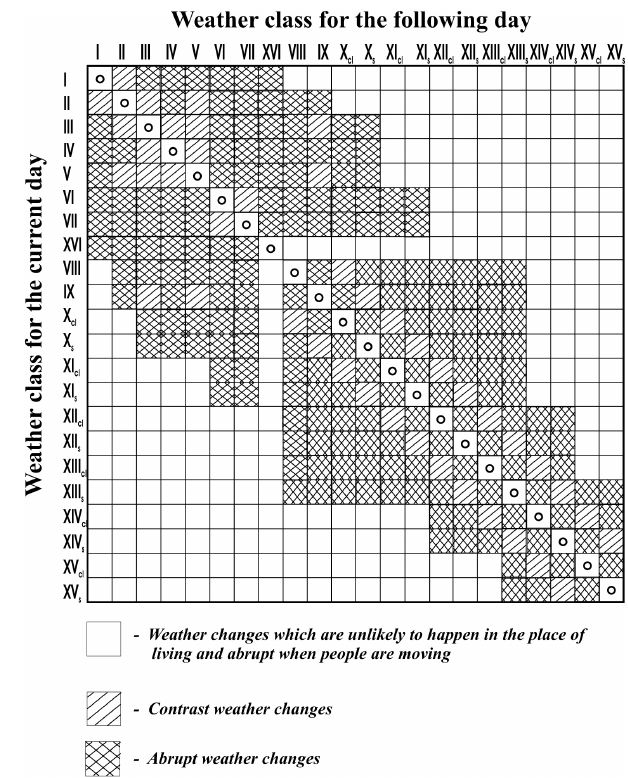
Figure 3. Scheme for determination the contradistinction of the weather changes (source: Baibakova et al.,